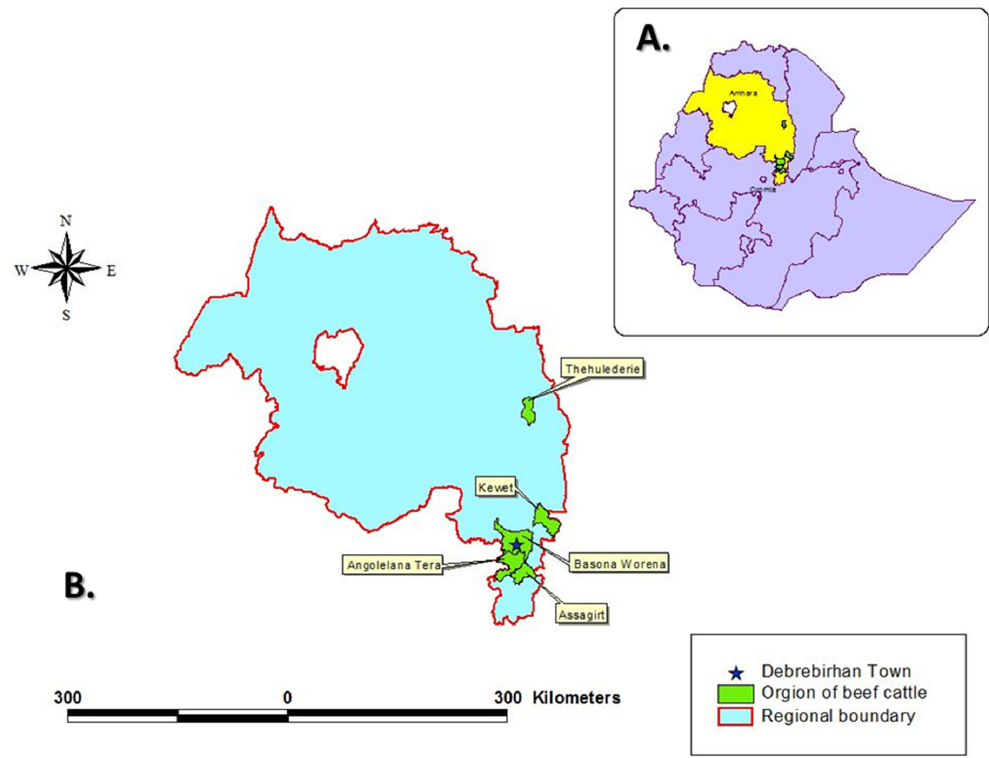
Figure 1. Geographical location of the study sites and beef cattle sources. ( A ) Map of Ethiopia with the Regional State of Amhara, in which this study was conducted, highlighted in yellow. ( B ) Map of the Regional State of Amhara with the town of Debrebirhan ( (cid:70) ) and the sampling areas of Thehulederie, Kewet, Angolelana Tera, Assagirt and Basona Worena highlighted in